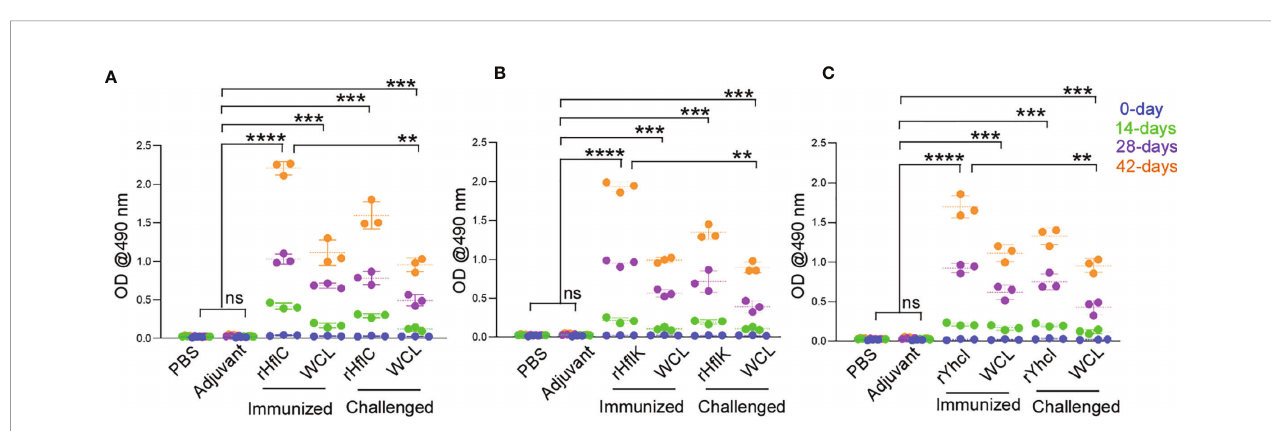
FIGURE 4 | Evaluation of humoral immune response in control and immunized mice groups by ELISA. (A) rH fl C antigen used, (B) rH fl K antigen used and (C) rYhcI antigen used. Graphs represent the mean + SD of the optical density sera obtained at different day intervals (0, 14, 28, 42 days before challenge) and after challenge. ns, no signi fi cant, **P < 0.05, ***P < 0.01, ****P < 0.0001. P values were obtained by comparison with control (PBS and Adjuvant) using Tukey ’ s multiple comparisons test by 2-way ANOVA. (WCL- Whole cell lysate of E. tarda